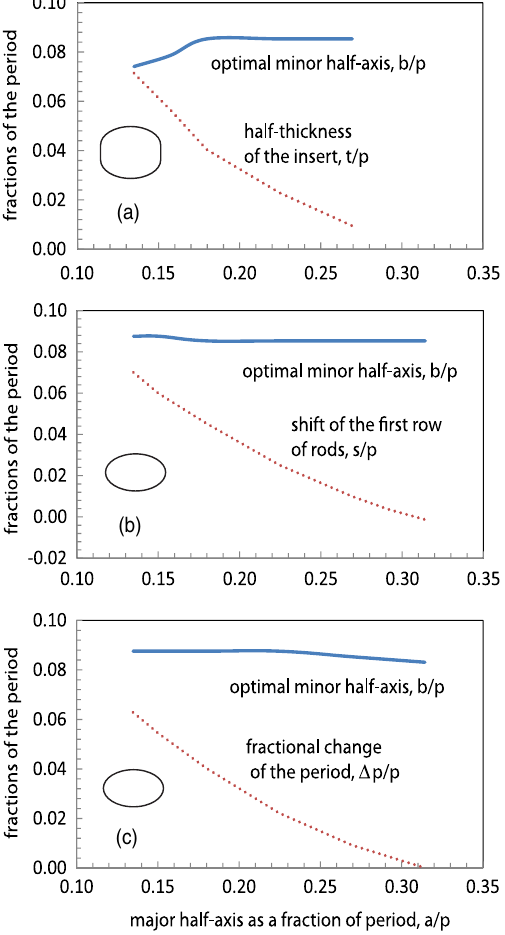
FIG. 4 (color online). Optimized minor half-axis of the ellip- tical rod and change in dimensions of the PBG structure as a function of the major half-axis of the elliptical rod for: (a) ellip- tical rods with frequency-compensating rectangular inserts; (b) regular elliptical first row of rods with the rods shifted towards the center of the resonator; (c) regular elliptical first row of rods with the reduced period of the whole PBG